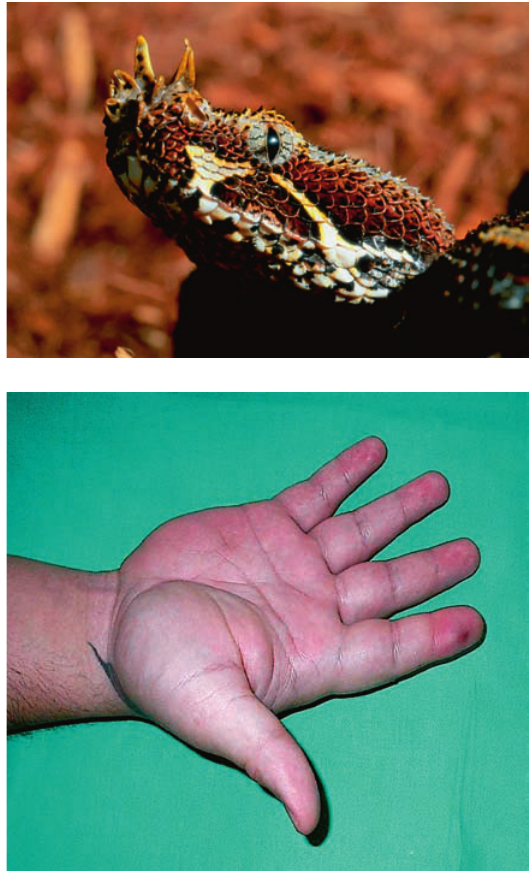
local consequences of the envenoming (photograph by Zsolt